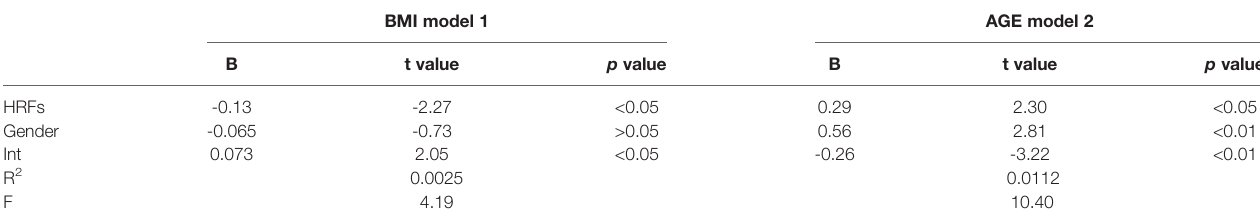
TABLE 8 | Model characteristics for the moderation